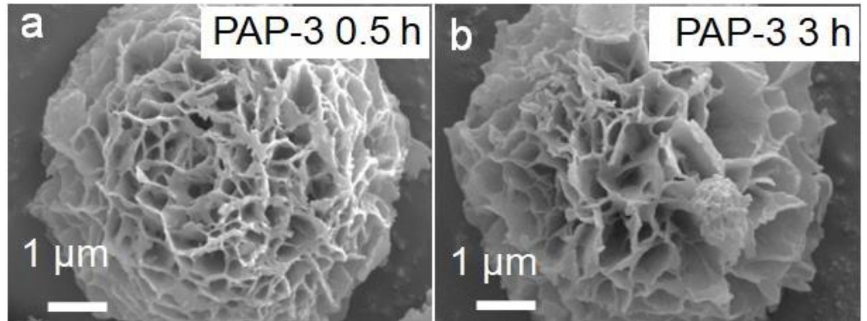
Figure 6. SEM images of dynamic covalent material PAP-3 formed at 0.5 h ( a ) and 3 h ( b ).